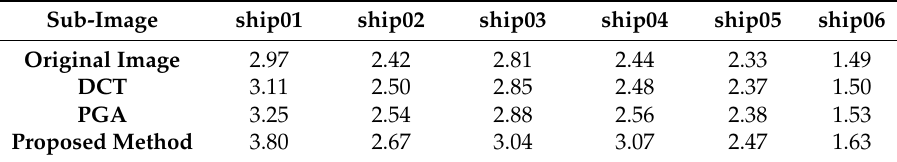
Table 3. The IC values of six